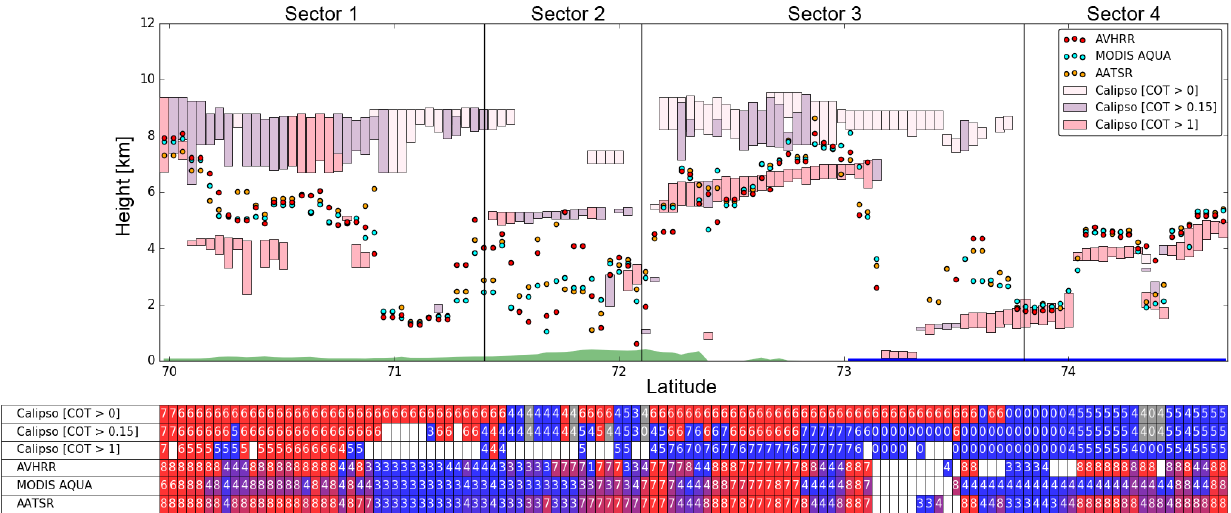
Figure 10. Vertical cross section of study area NA1 (North America 1) along the CALIOP track at 5km horizontal resolution. Top: CTH for CC4CL retrievals (coloured points) and CALIOP measurements (vertical bars), and surface elevation and surface type (blue is open water, green is land, grey is snow/ice). The CALIOP data are shown for those pressure layers where the cumulative top-to-bottom COD exceeds a threshold value of 0 (top layer), 0.15 (mid-layer), and 1 (bottom layer). Bottom: cloud mask/phase (ice to water is red to blue, cloud-free is white, not determined is grey) and type (see Table 4 for key–value pairs) for all three CALIOP layers and CC4CL retrievals. For CC4CL, cloud phase was averaged when resampling, and cloud type was assigned to the most frequent class per grid box. Sectors of characteristic cloud fields are separated by black vertical lines. Number of pixels n =